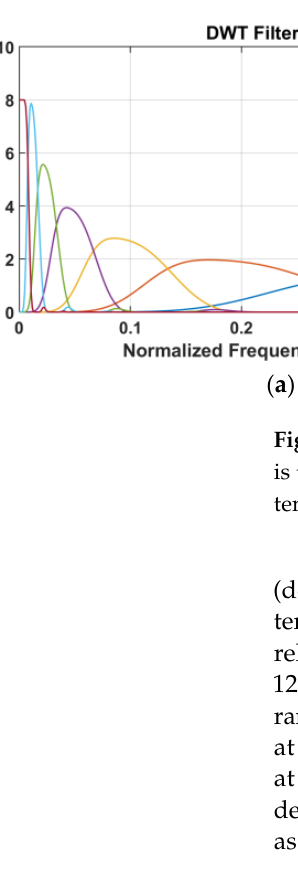
Table 1. Set-up for WRF